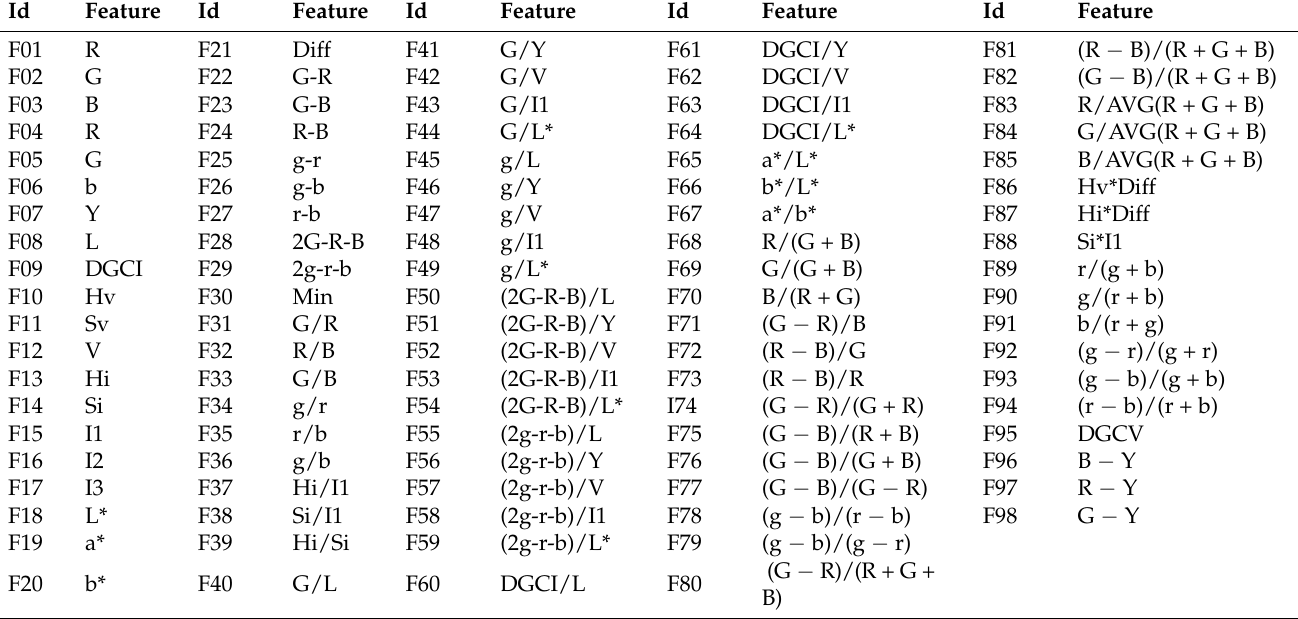
Table 1. Color feature